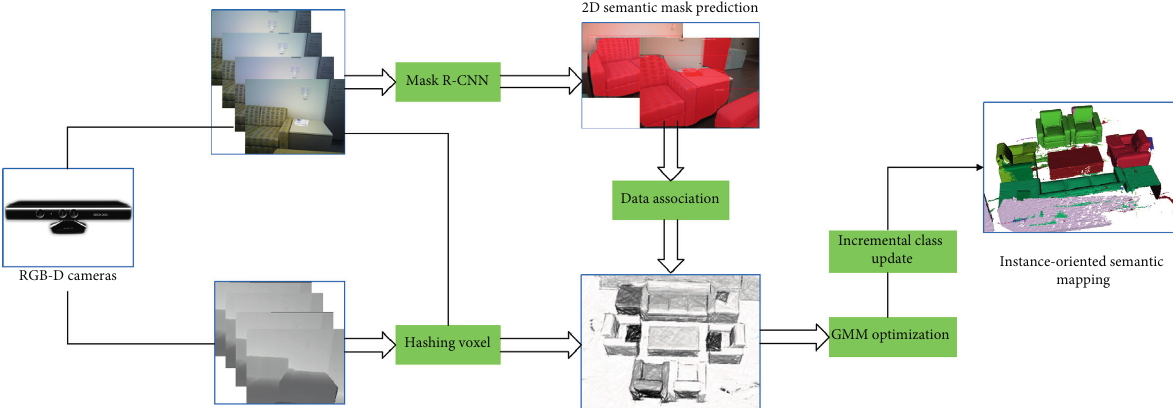
Figure 1: Overview of our incremental instance-level 3D scene reconstruction method. From continuous frames of an RGB-D sensor, our system performs on-the-fly reconstruction and 3D semantic prediction. All of our processing is performed on a frame-by-frame basis in an online fashion, thereby making it useful for real-time